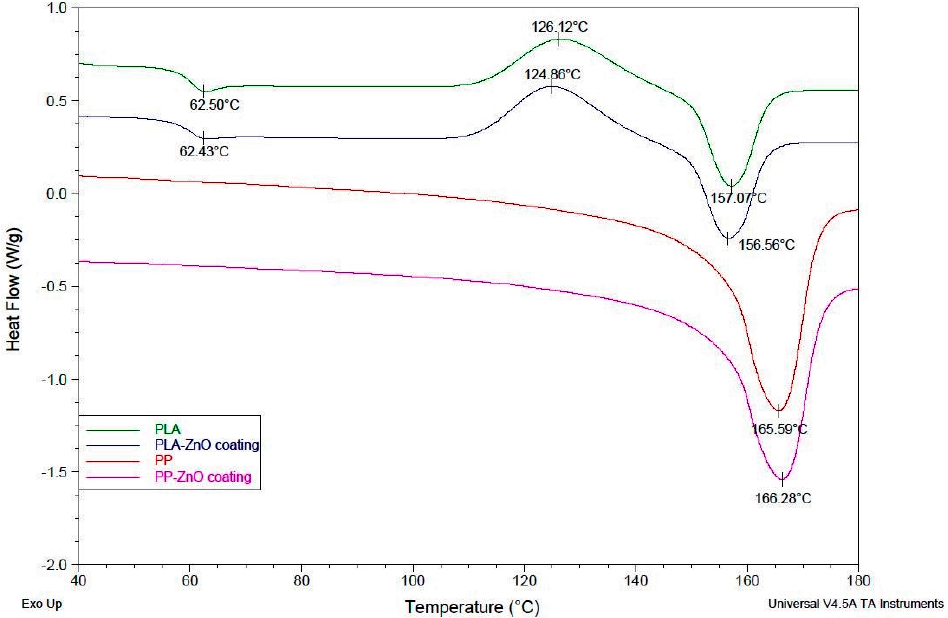
Figure 8. DSC thermographs of the PLA, ZnO@PLA, PP and ZnO@PP coated samples. No significant difference was observed between the coated and uncoated samples considering a p -value < 0.05.